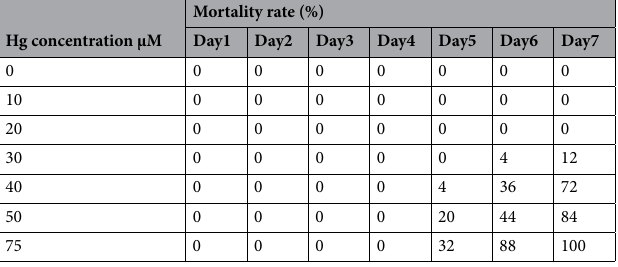
Table 1. The mortality rate of S. caninervis in the different concentrations of Hg addition.